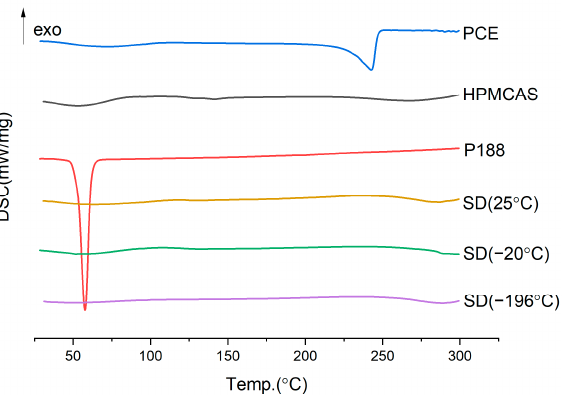
Figure 5. DSC diagram of solid dispersion prepared by different cooling temperature.